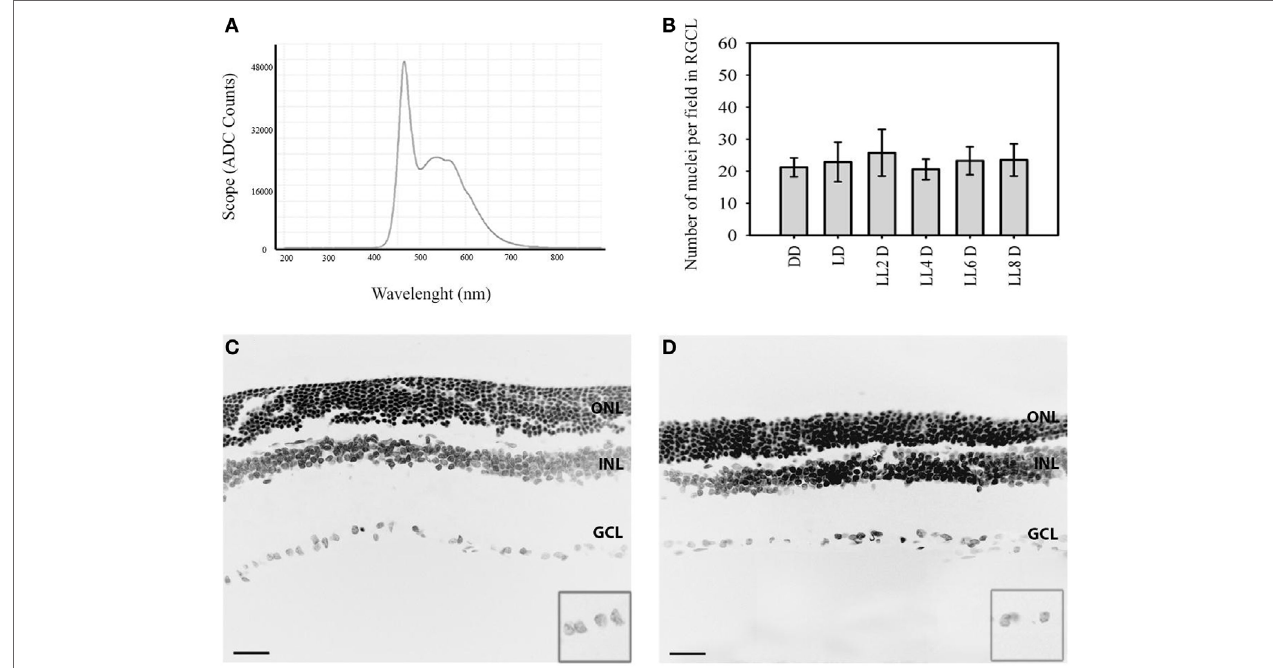
FigUre 1 | Representative nuclear staining in retinal images in responses to LL treatment: (a) spectral distribution of white light-emitting diode light source. (B) Quantification of retinal ganglion cell nuclei at DD (constant dark), LD 8, LL 2, LL 4, LL 6, LL 8 days. (c,D) Representatives retinas showing DAPI staining in LD8 control, Wistar rats maintained in LD cycle for 8 days (c) and LL8-treated Wistar rats maintained in LL during 8 days (D) . Data are mean ± SD ( n = 1 animal/group) from five independent experiments, p > 0.05 by a non-parametric Kruskal–Wallis ANOVA. Insert, magnification of GCL. Barr 10 µm. ONL, outer nuclear layer; INL, inner nuclear layer; GCL, ganglion cell